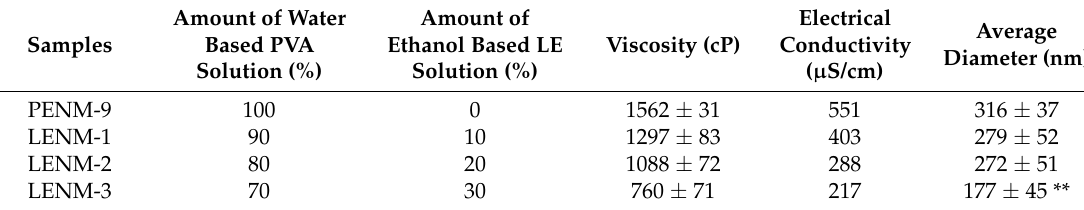
Table 3. Properties of Lithospermum erythrorhizon electrospun nanofibrous membranes (LENMs).